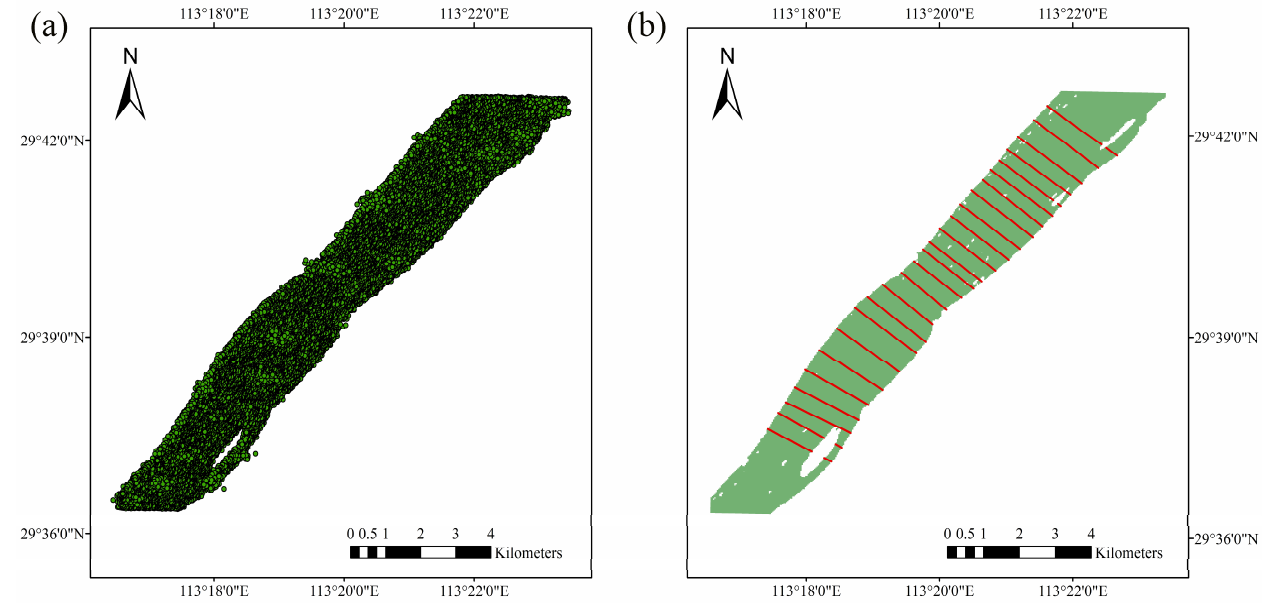
Figure 2. SWOT ‐ river ‐ product and river ‐ width extraction from the SWOT river product. ( a ) SWOT “pixel cloud” product simulated by the SWOT_HYDROlOGY_TOOLBOX; ( b ) River-width extraction based on the simulated SWOT river product. Take the Luoshan reach of the Yangtze River on 2 May 2021 as an example.